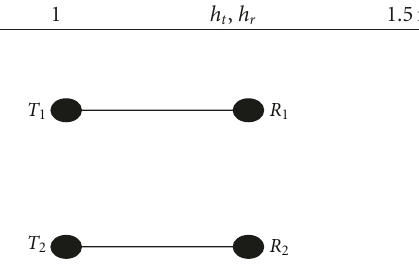
Figure 5: A sample